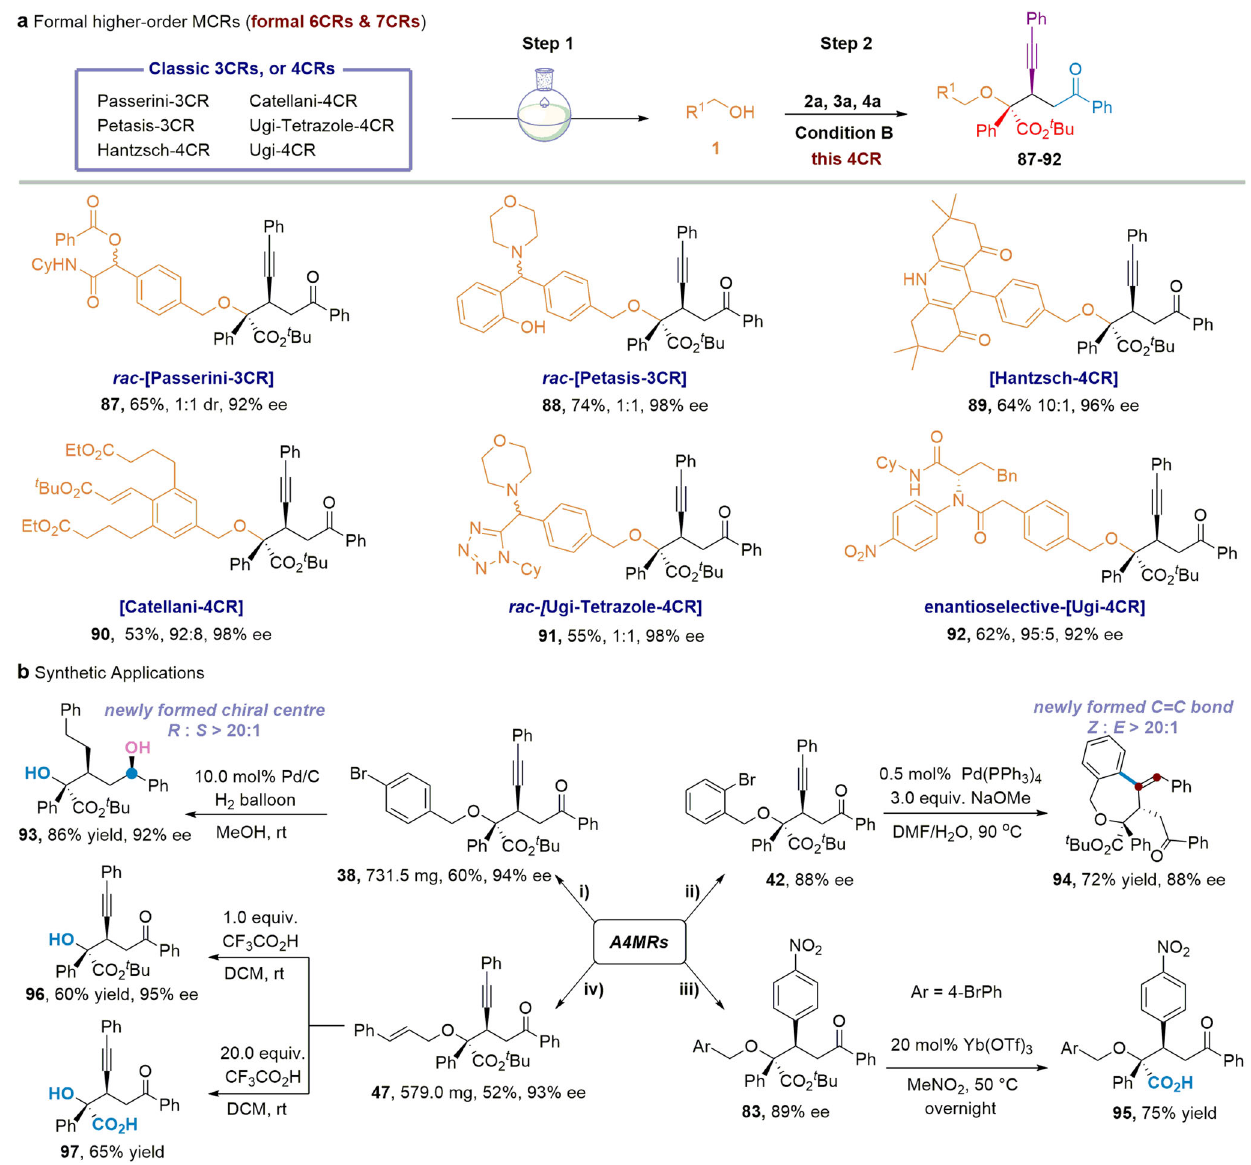
Fig. 4 | Formal higher-order MCRs design and synthetic applications. a Formal higher -order MCRs design. b Synthetic applications. NOTE: The other diaster- eomer 87 ’ ofcompound 87